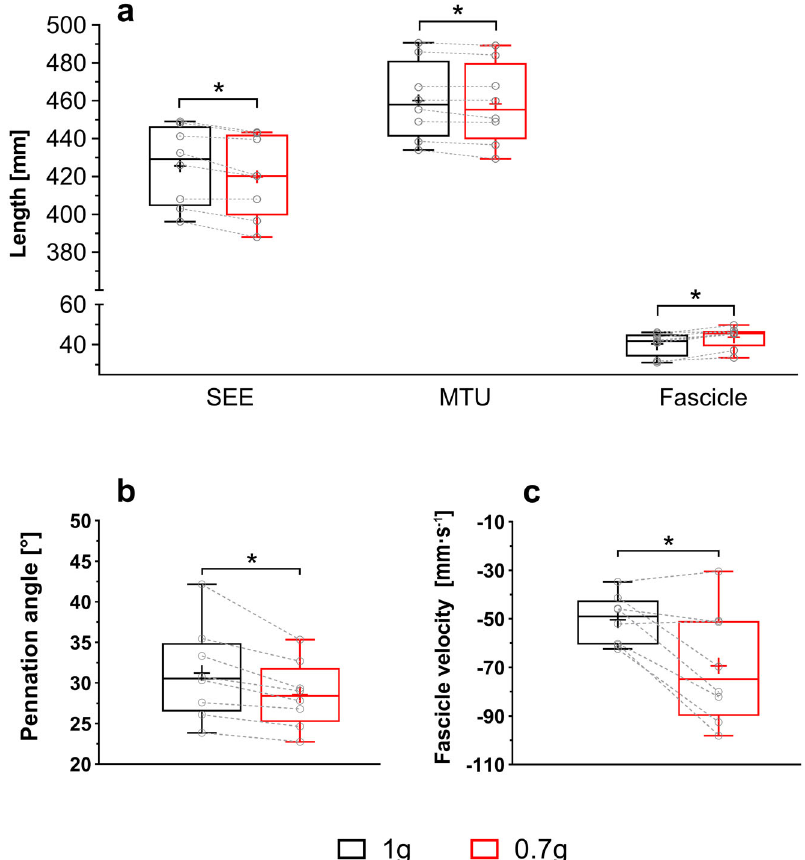
Fig. 2 GM fascicle ‒ SEE behavior at the time of peak SEE length when running at 1 g and simulated 0.7 g. SEE length ( a , left), MTU length ( a , middle), fascicle length ( a , right), pennation angle ( b ), and fascicle velocity ( c ) at the time of the peak SEE length differ between running at 1g (black box) and simulated 0.7g (red box). The lower and upper parts of the box represent the fi rst and third quartile, respectively. The length of the whisker represents the minimum and maximum values. The horizontal line in the box represents the statistical median of the sample; + the mean of the sample; ○ individual data points; * signi fi cantly different (two-tailed paired t -test) from 1g ( P ≤ 0.05). n = 8